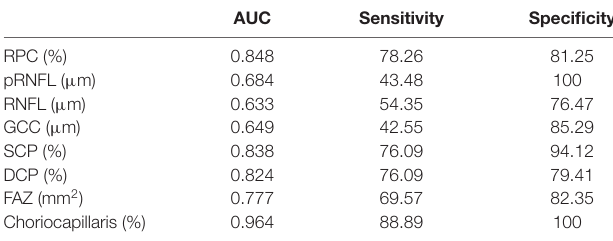
TABLE 3 | ROC curve analysis of the macula and choriocapillaris of cerebral infarction and healthy controls. AUC